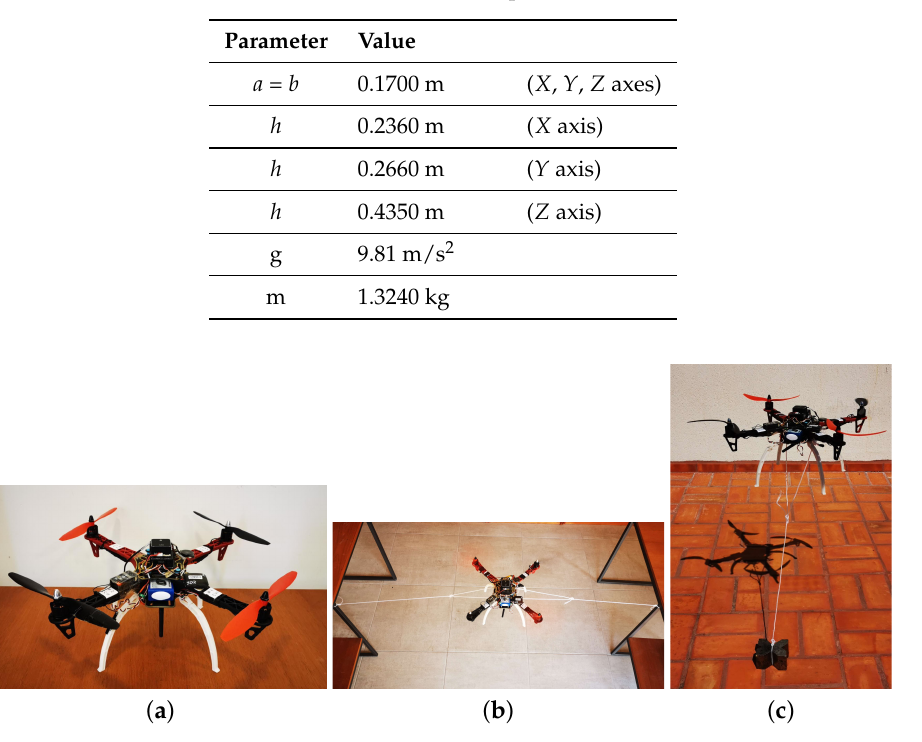
Table 2. Quadrotor UAV parameters.